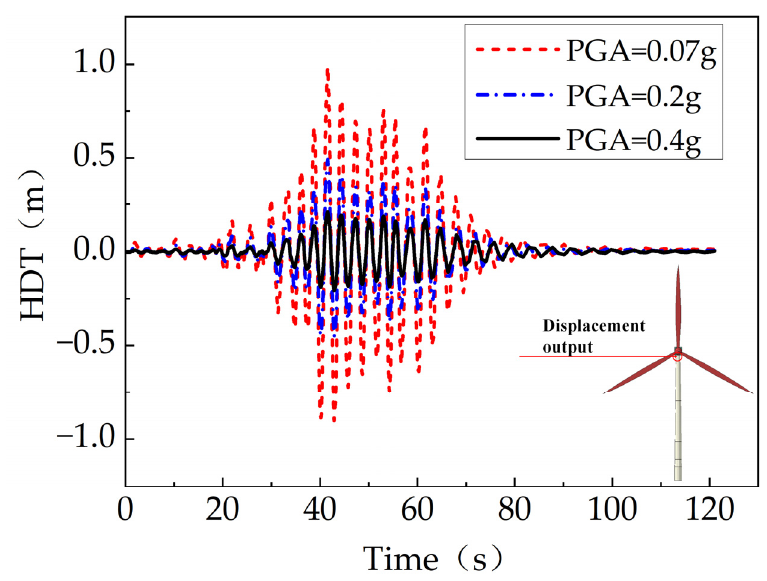
Figure 8. El Centro earthquake.